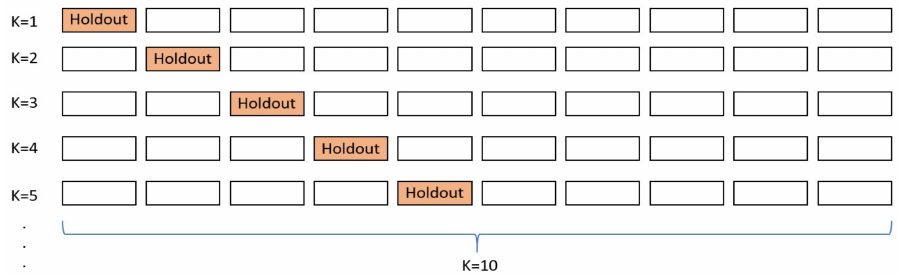
Figure 26. Model tuning through cross